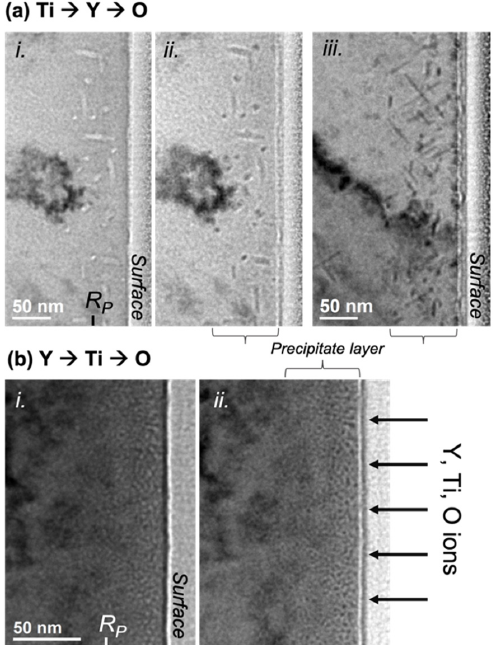
Figure 1. Cross-sectional defocused bright field micrographs of Fe-10%Cr samples implanted with Ti, Y, and O ions at room temperature and subsequently annealed at 800 ◦ C for 2 h. Ion implantations were performed in the sequential orders ( a ) Ti → Y → O and ( b ) Y → Ti → O. Precipitates are observed in regions indicated with curly braces (“precipitate layer”), close to the mean projected range of implanted ions, R p . Precipitates are evidenced by using Fresnel contrast. In picture (i), the precipitates are observed in underfocus conditions, where they appear light with a contrasting surrounding Fresnel fringe. They are otherwise evidenced in overfocus conditions with reverse contrast in pictures (ii,iii). Pictures (i,ii) are from the same area, whilst picture (iii) shows a different grain of the thin foil. Irregular dark contrasts, visible in every picture, are induced by deformation of the thin foil.